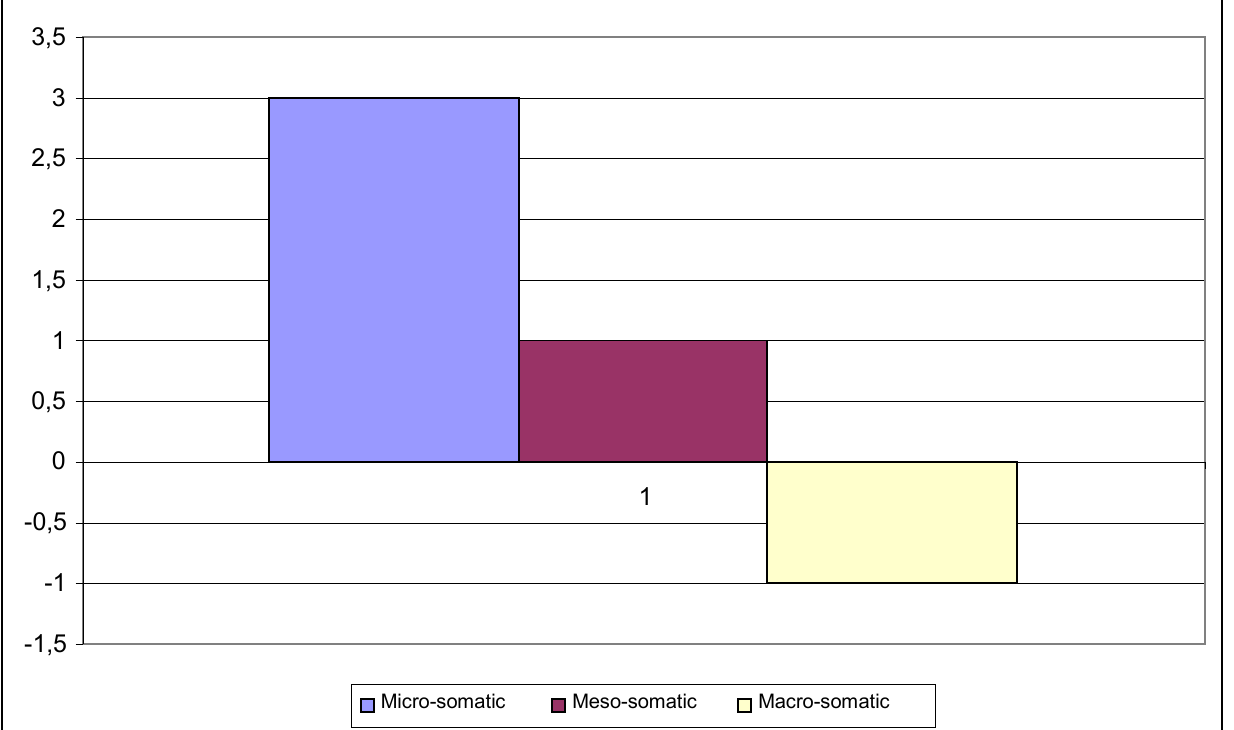
Fig.1. Level of somatic health of different somatic types’ students Micro-somatic students have higher mark of somatic health. Their level was assessed as below average. The level of meso- and macro-somatic students was assessed as